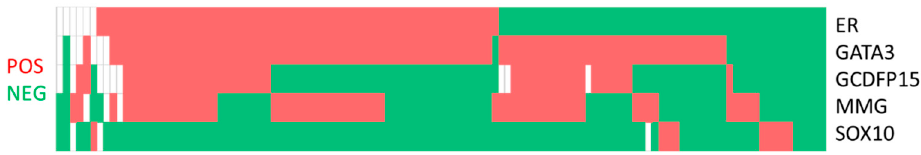
Figure 1. Co-expression pattern of estrogen receptor (ER), GATA3, gross cystic disease fluid protein-15 (GCDFP15), mammaglobin (MMG) and SOX10 in metastatic breast cancer. Table 3. Co-expression pattern of GATA3, gross cystic disease fluid protein-15 (GCDFP15), mammaglobin (MMG) and SOX10 at cut-offs of (a) ≥ 1% (any intensity), (b) ≥ 5% (any intensity) and (c) ≥ 5% (moderate to strong intensity).